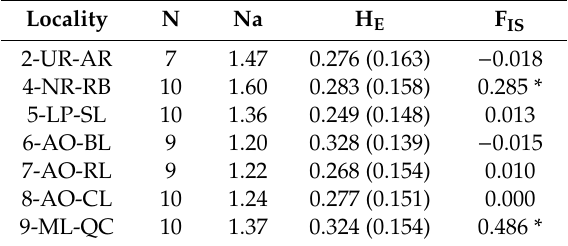
Table 3. Genetic diversity of Rhamdia quelen locality samples based on RAD-seq genotypes. Locality N Na H E F IS 2-UR-AR